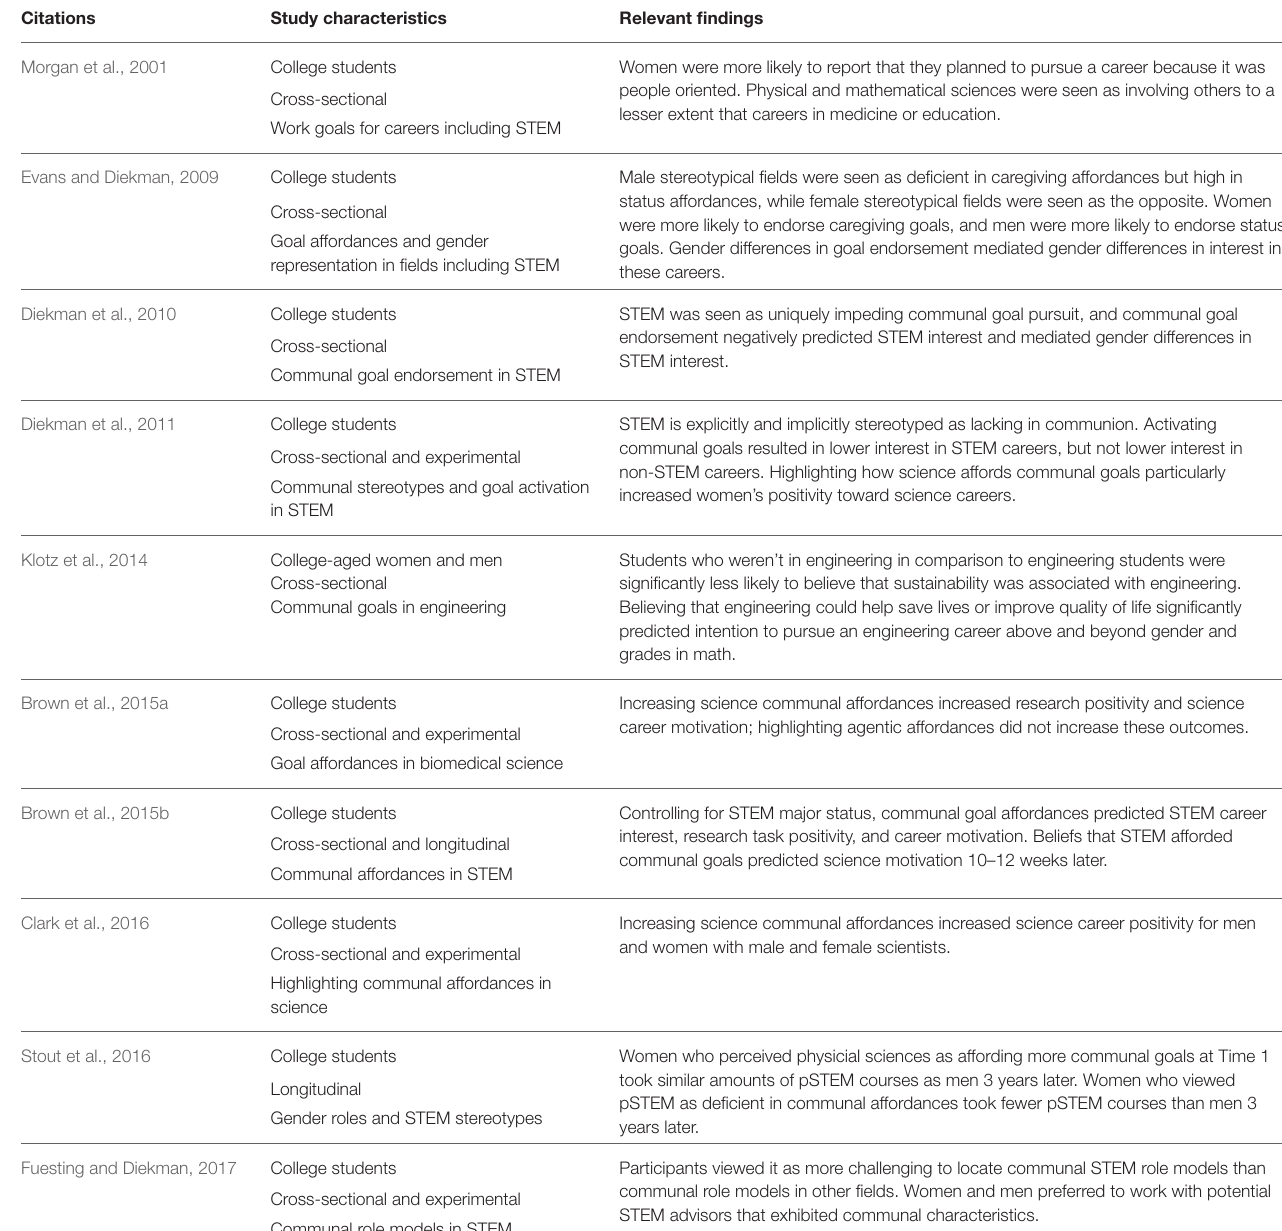
TABLE 1 | Included studies in the focused review with a focus on